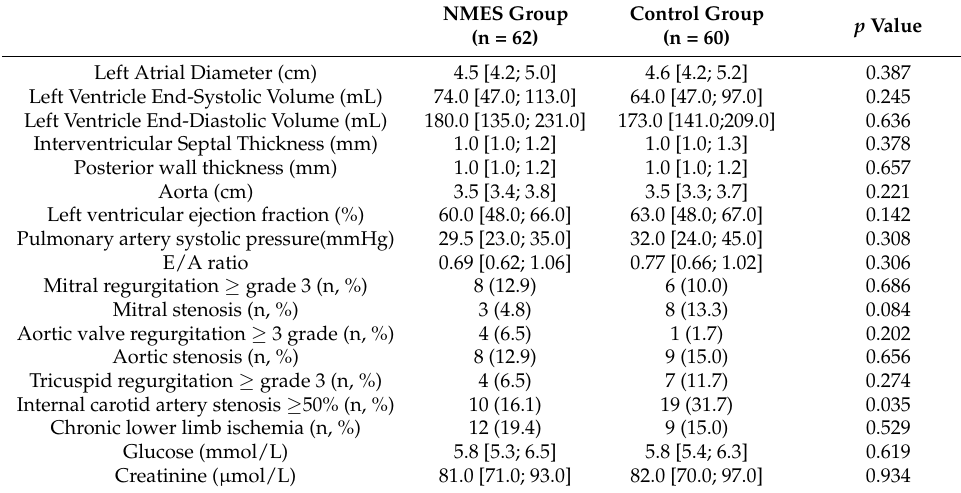
Table 2. Baseline characteristics of patients (laboratory and instrumental